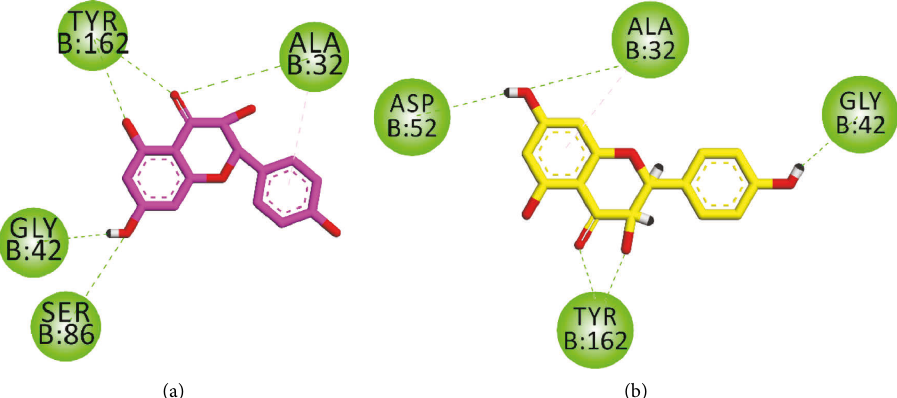
Figure 3: 2-D interaction plots of isolated flavonoid obtained via (a) MOE dock (b) AutoDock into the active site of homology modeled Lm DHFR.